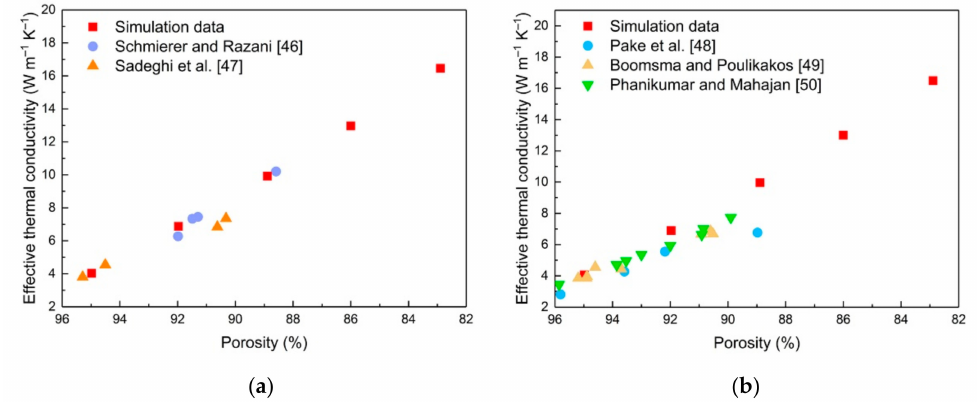
Figure 7. Comparison of simulation data and experimental data in the literature: ( a ) Vacuum; ( b )